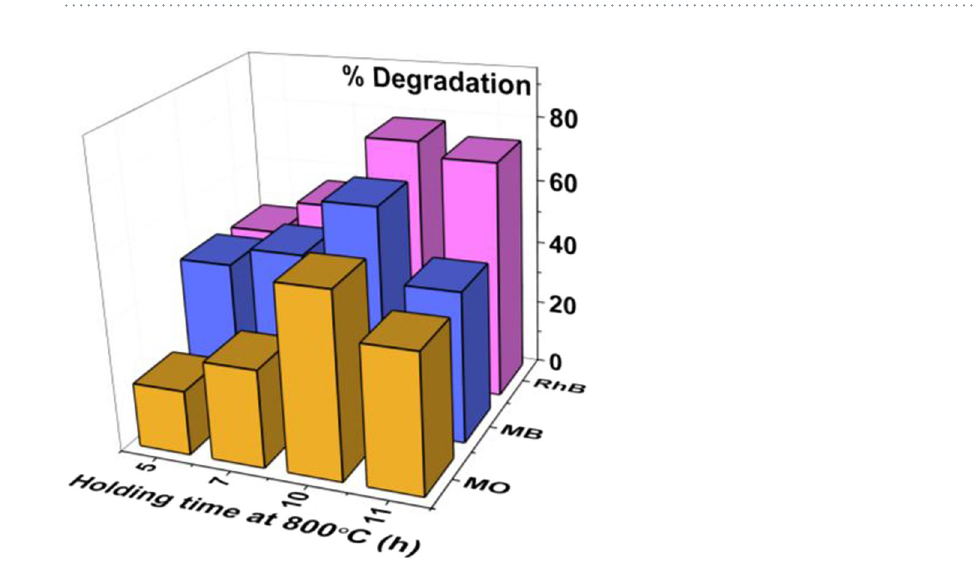
Figure 11. Comparative bar chart of the degradation of dyes after 120 min